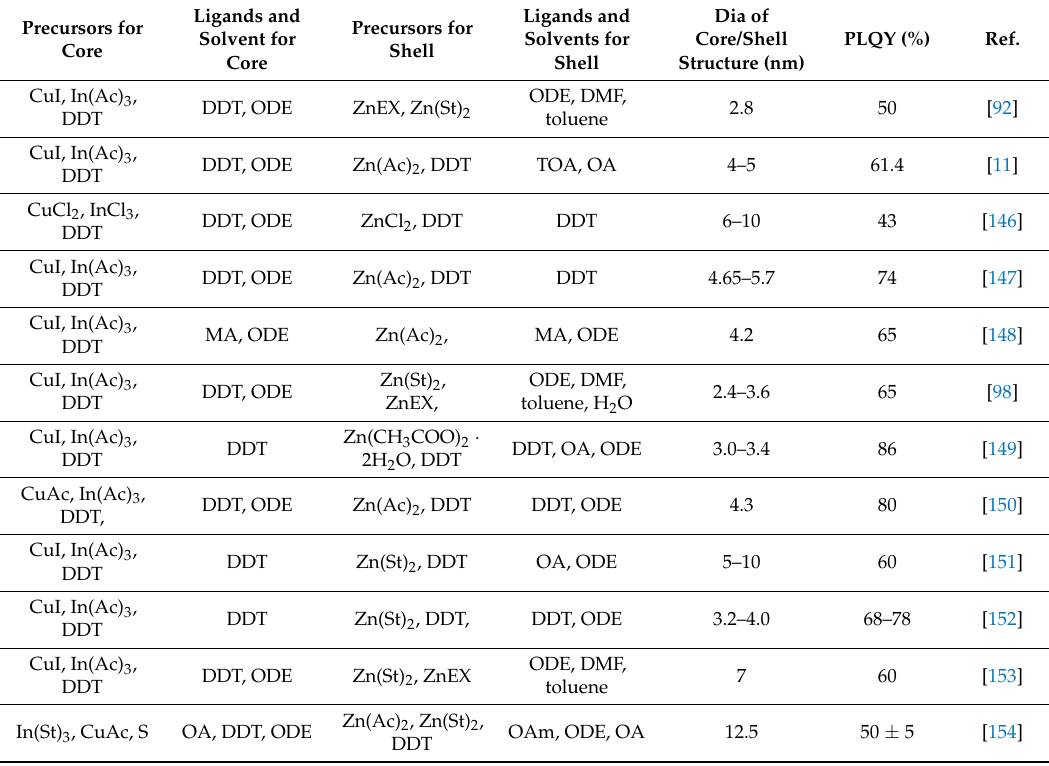
Table 2. Overview of the synthesis of CIS/ZnS